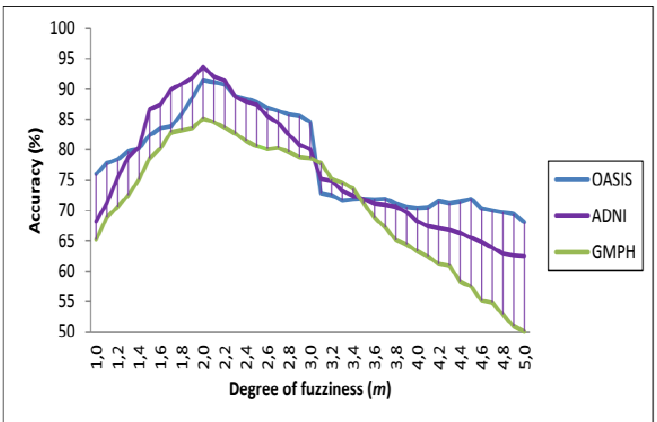
Figure 13. Accuracy results of the MRI / PET multimodal classification with SVDD (RBF function with σ = 0.5) for the ADNI, OASIS, GMPH databases during the variation of the fuzzy parameter m in the range [1, 5] with a step of 0.1.